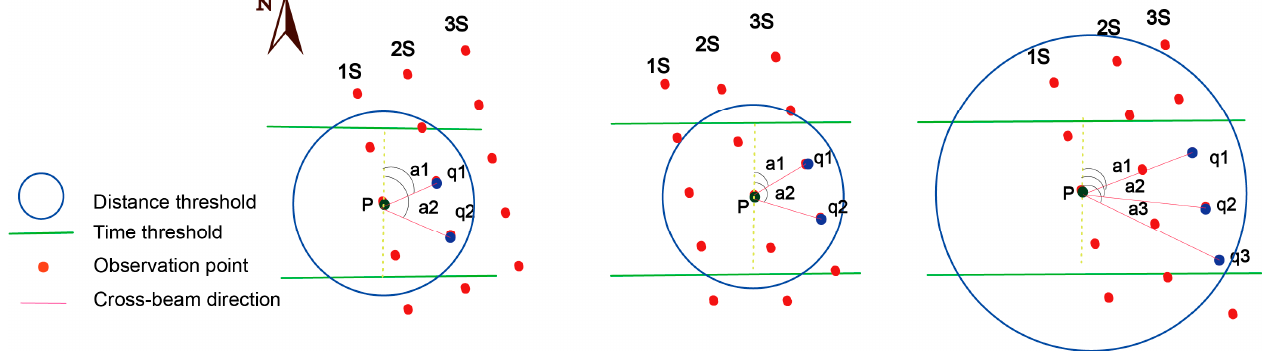
Figure 4. Schematic diagram of calculation method for the cross-beam DOV (‘a1’, ‘a2’ and ‘a3’ is the azimuth of two adjacent observation points).